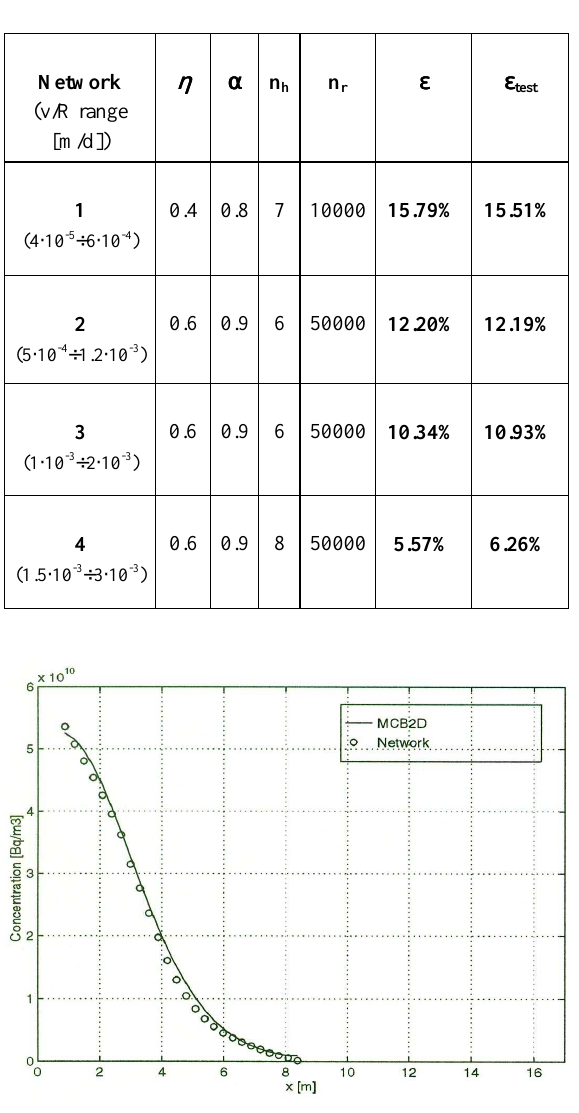
Table 4.1. Networks parameters and performances.